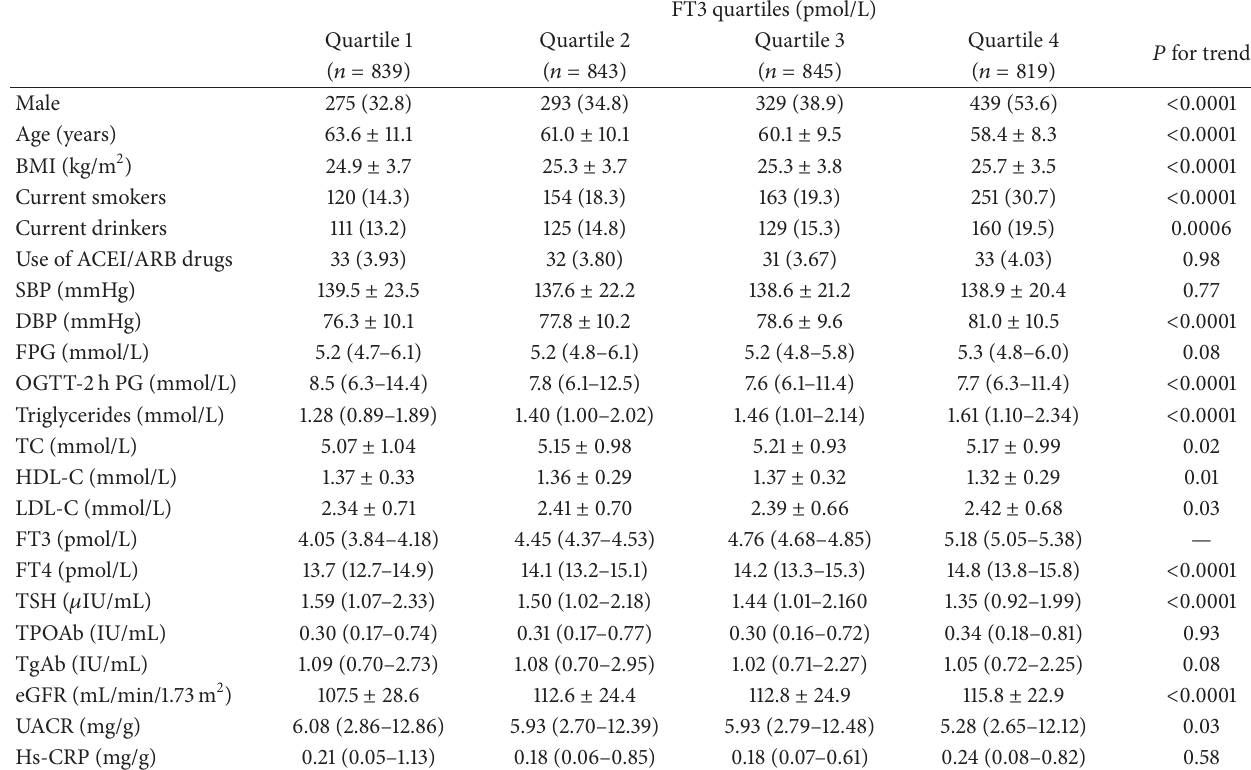
Table 1: General characteristics of the study